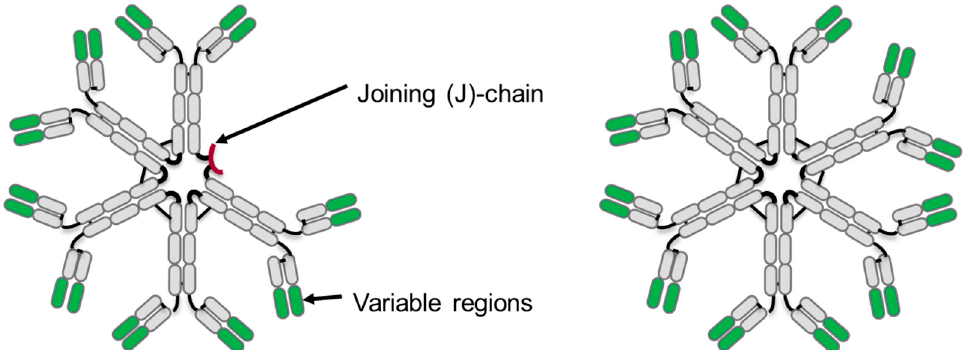
Figure 1. Schematic diagram of an immunoglobulin M (IgM) antibody pentamer ( left ) and hexamer ( right ). Constant regions are shown in gray and variable regions in green, and also shown on the IgM pentamer is the small joining chain (J-chain) in red.